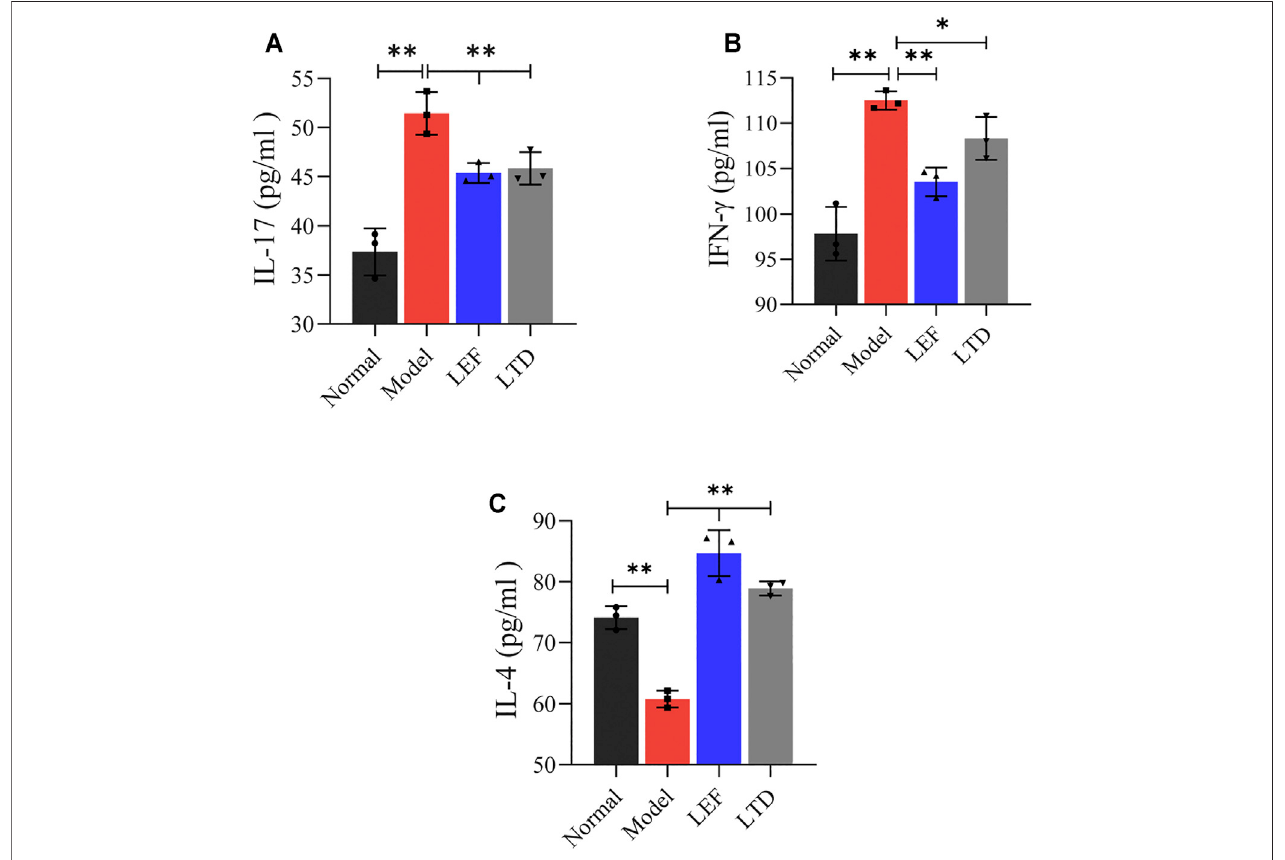
FIGURE 7 | The levels of pro-in fl ammatory and anti-in fl ammatory cytokines in serum detected by Elisa. (A) The level of IL-17 cytokine. (B) The level of INF- γ cytokine. (C) The level of IL-4 cytokine. All data are presented as the means ± S.D. ( n (cid:1) 3). * p < 0.05 ** p < 0.01.